Question: Describe this figure in one sentence.
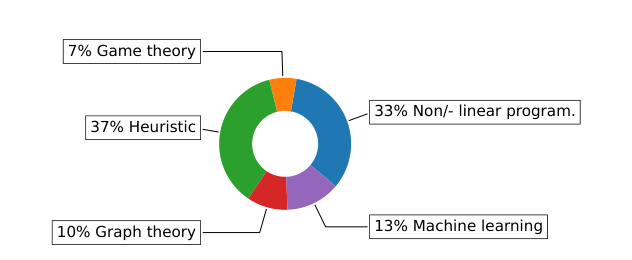
Answer: Percentages of research articles presenting different methods.